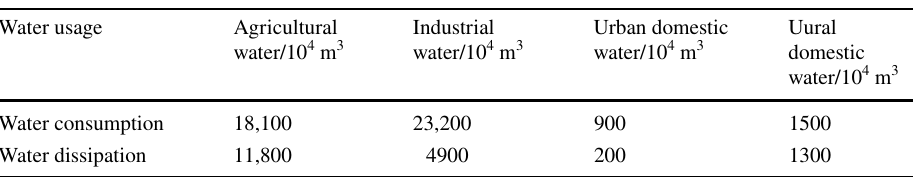
Table 2 Values of NSC indicator of the Fuyang district between 1995 and 2003 (HEEB